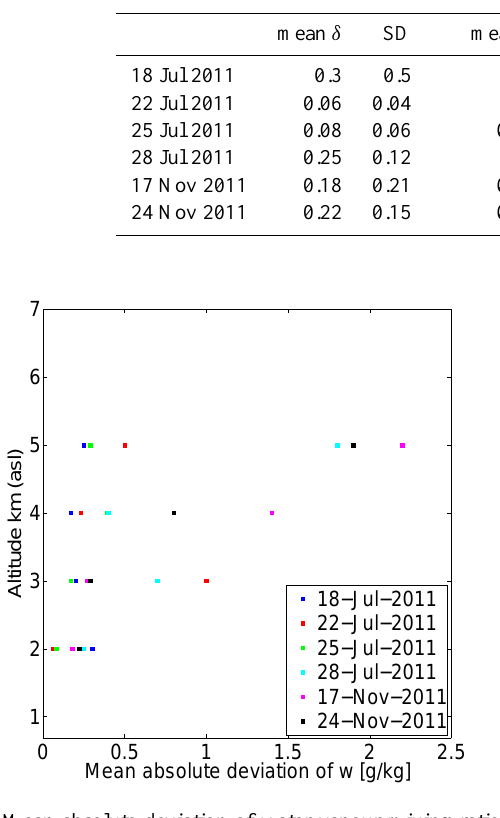
Fig. 2. Water vapour mixing ratio profiles from radiosonde and Ra- man lidar during nighttime on (a) July 22nd and (b) July 25th, 2011.